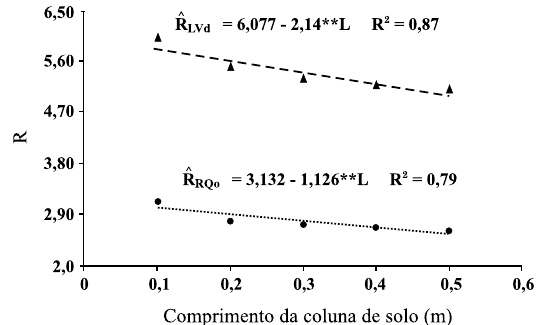
Figura 1. Fator de retardamento (R) de potássio estimado (linhas) e médias dos valores experimentais observados no Latossolo Vermelho distrófico (LVd) ( ) e no Neossolo Quartzarênico órtico (RQo) ( ), em função do comprimento da coluna de solo (L). **: signifi- cativo a 1 %, pelo teste